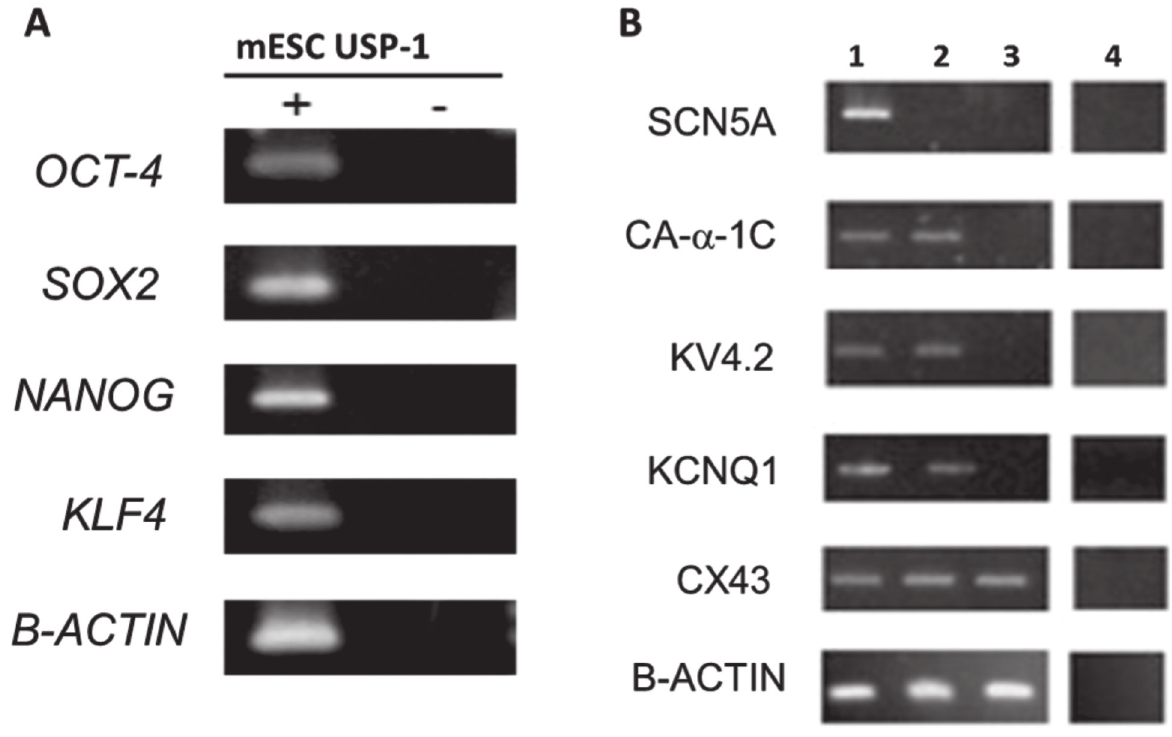
Figure 1 - Transcriptional analysis of mESC. A: RT-PCR products of the pluripotent related transcripts of genes. The RT (+) and (-) samples refer to amplification of RNA in the presence and absence of reverse transcriptase, respectively. Amplification of b-actin transcript was used as the internal control; B: RT-PCR products of the genes coding for ion channels. These cells were used for total RNA extraction and RT-PCR amplification as described in methods. Lane 1: Heart (positive control), lane 2: USP-1, lane 3: MEF and lane 4: amplification of RNA in the absence of reverse transcriptase. Amplification of β-actin transcript was used as the internal control. Both analyzed on a 1.5% agarose gel electrophoresis and visualized by ethidium bromide